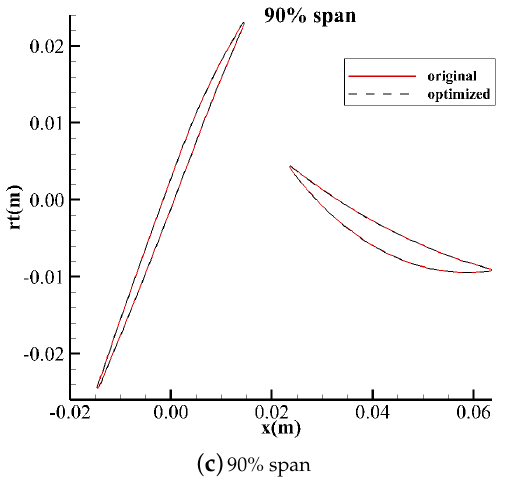
Figure 18. Comparison of blade profiles at three different spans for the NASA Stage 35.